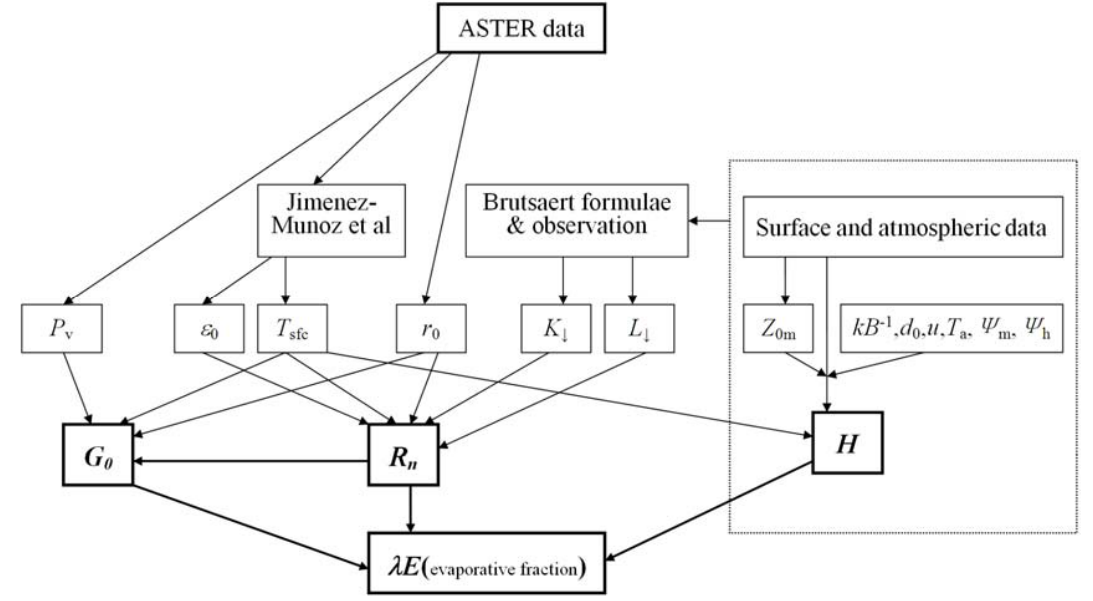
Fig. 2. Diagram of parameterization procedure by combining ASTER data with field observations. ( P v is vegetation coverage and kB − 1 is the parameterization for excess resistance for heat transportation.)